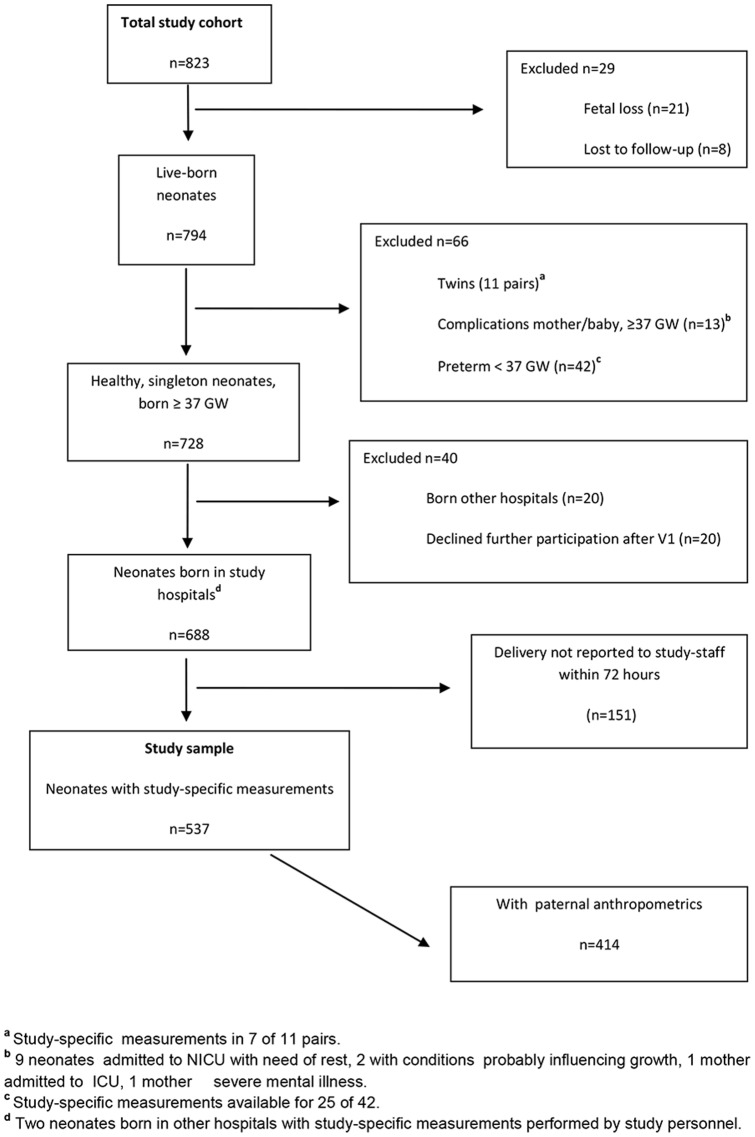
Flow diagram showing parent-neonate-pairs selected for analysis.